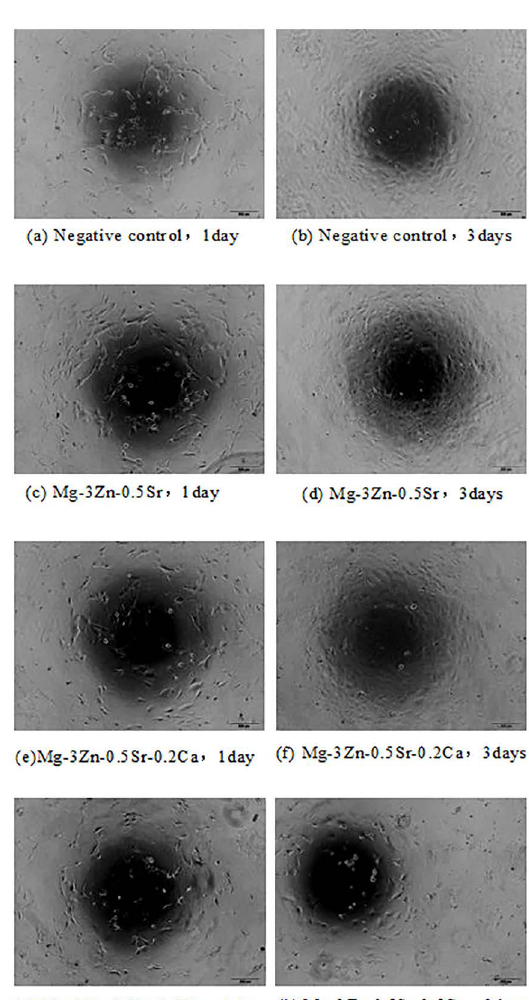
Figure 6 . The morphologies of mouse osteoblasts cultured in MgZnSrCa extraction medium after 1 and 3days, (a),(c),(e)and(g) cultured for 1day; (b),(d),(f)and(h) cultured for 3